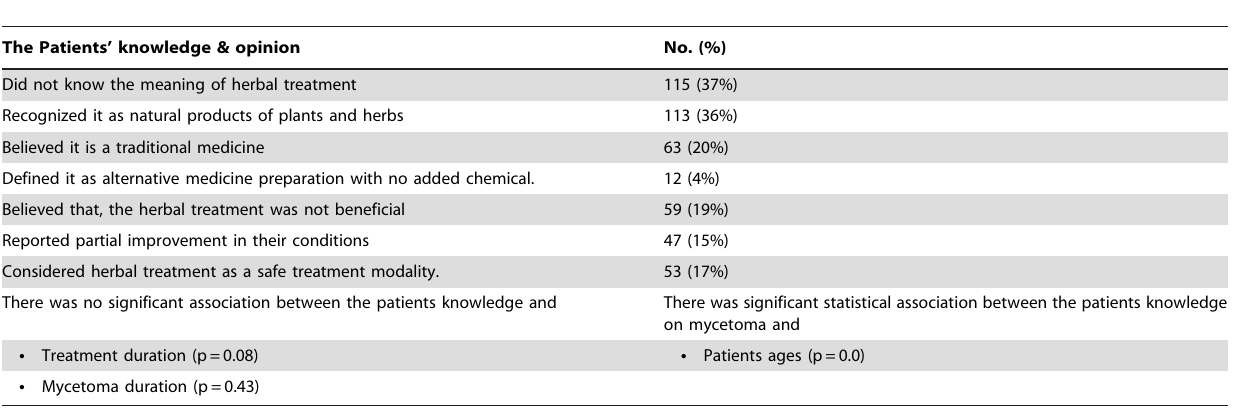
Table 3. The study population knowledge and opinion on herbal treatment.